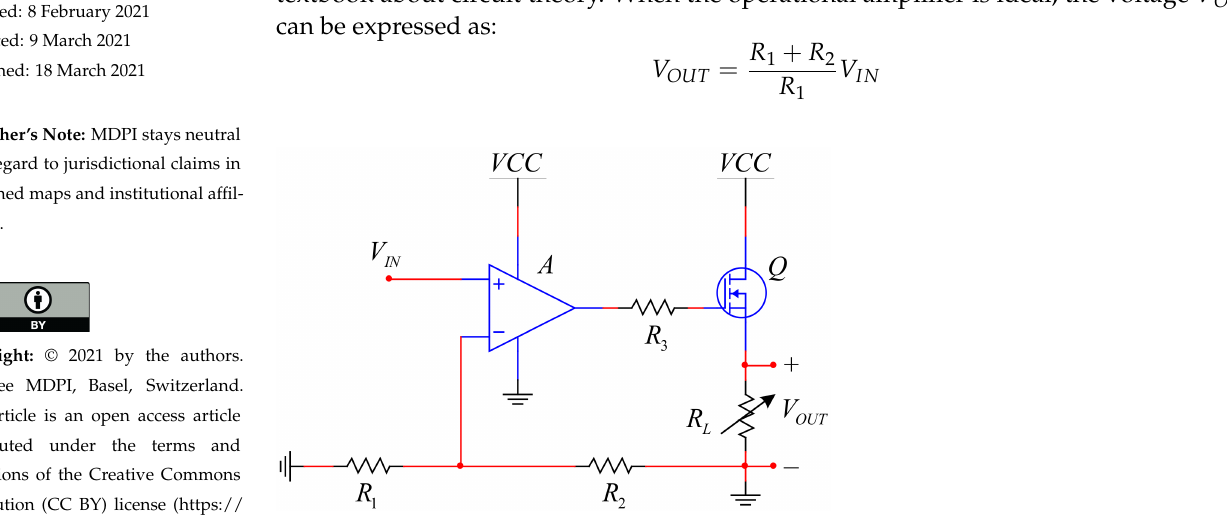
Figure 1. Current expansion circuit for operational